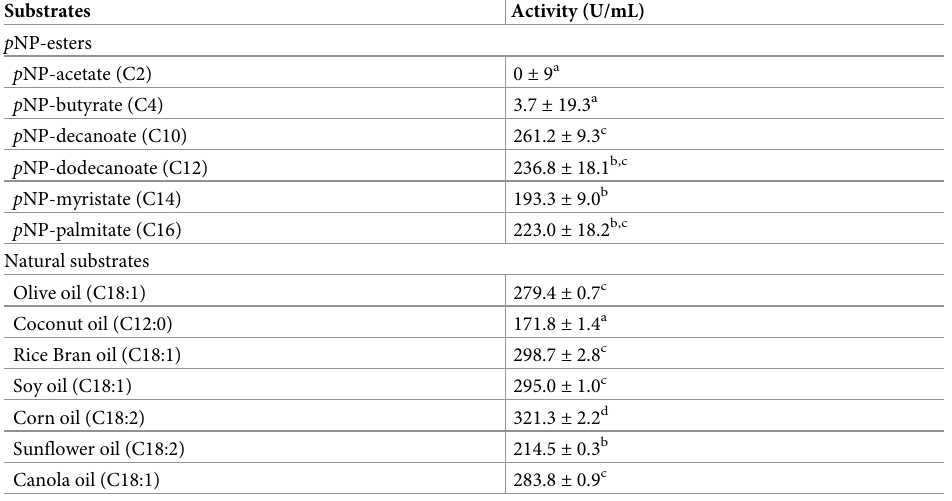
Table 3. Hydrolysis of 5M mutant